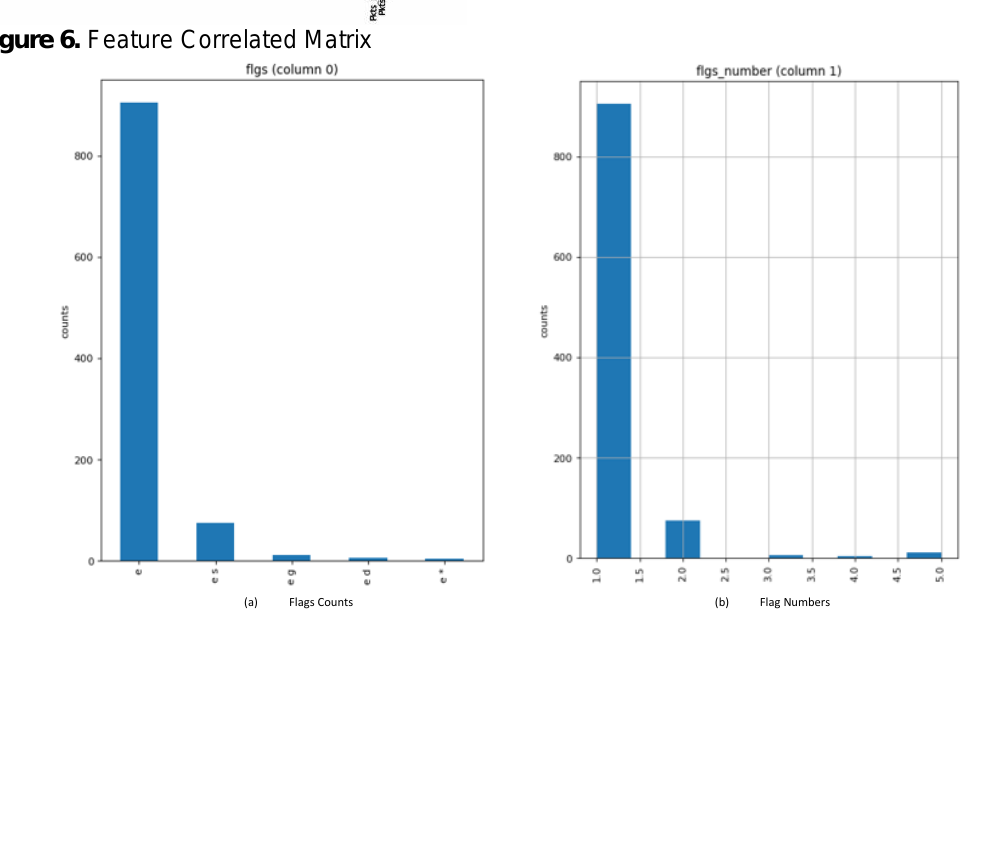
Figure 6. Feature Correlated